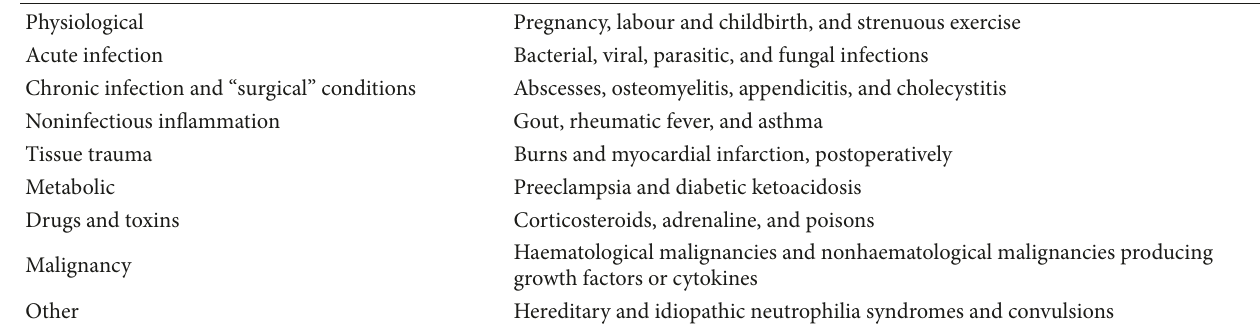
Table 2: Examples of causes of neutrophilia [1,